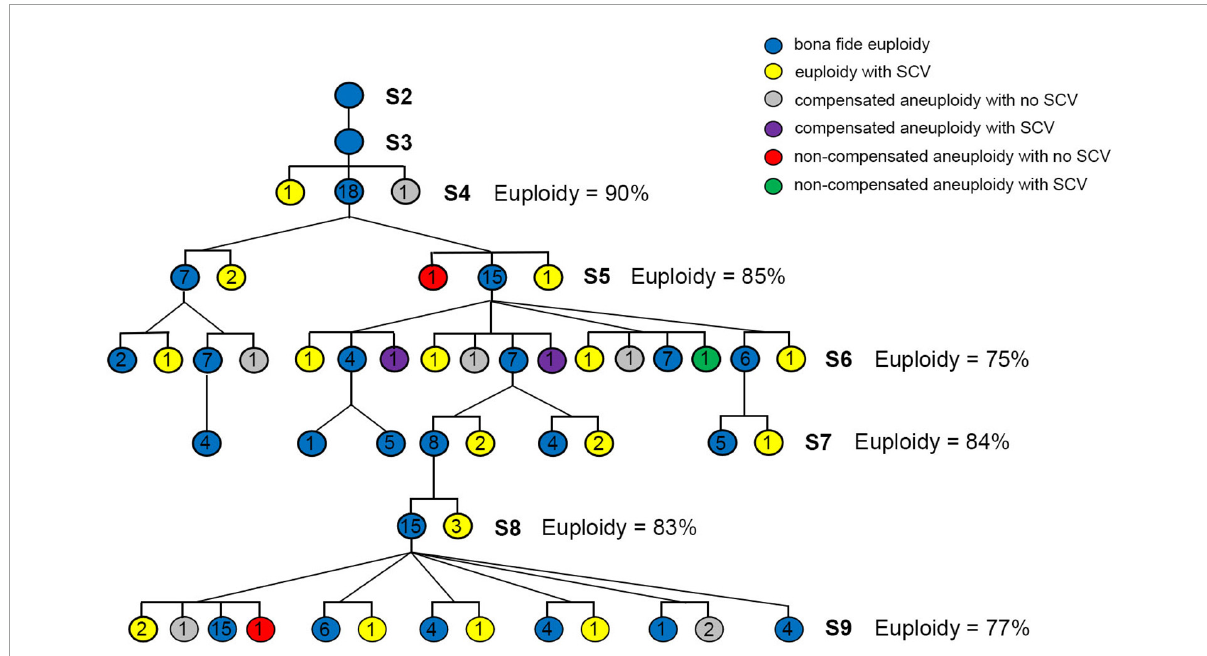
FIGURE5 Construction of an independent pedigree starting from a randomly chosen S3 plant derived from the same seeding S2 plant that gave rise to the chromosomal unstable linkage described in Figure 1 , and karyotype analysis. The pedigree consisted of seven consecutive generations of selfing by selecting one random euploid individual at each of the intervening generation (S3–S9) to produce the next generation. From 18 to 44 individual plants were randomly chosen for karyotyping in each generation to calculate the frequencies of euploidy. The six colored circles represent the six karyotypic categories, and the numbers in the circles represent the number of individuals contained in each